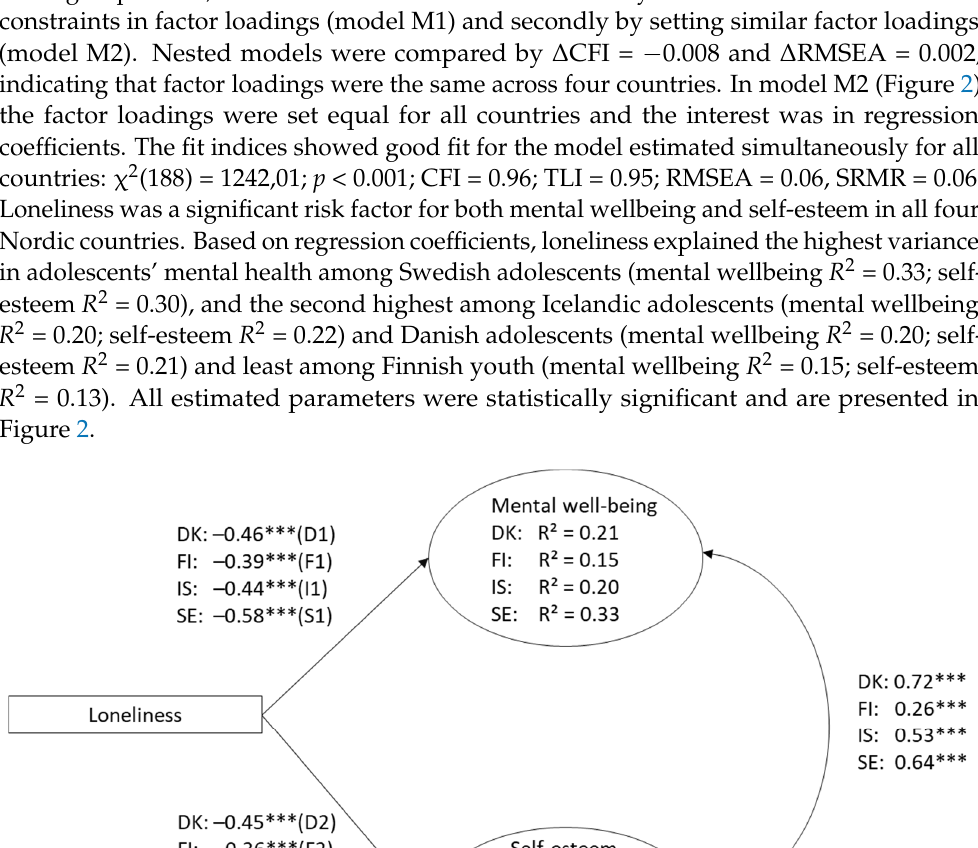
Table 4. Model fit indices for Denmark, Finland, Iceland, and Sweden and multi-group invariance across Nordic countries. Model